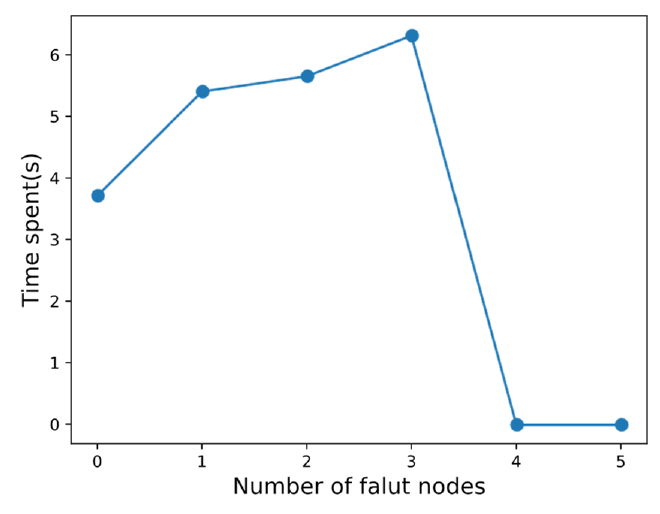
Figure 13. Fault tolerance of VPPBN.